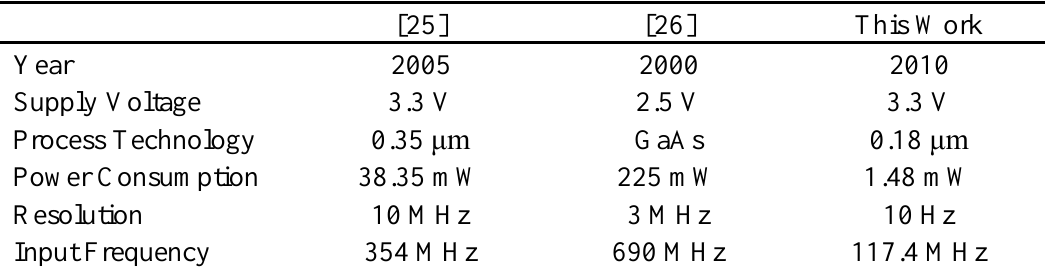
Table 2. Benchmark with other works of SAW interface